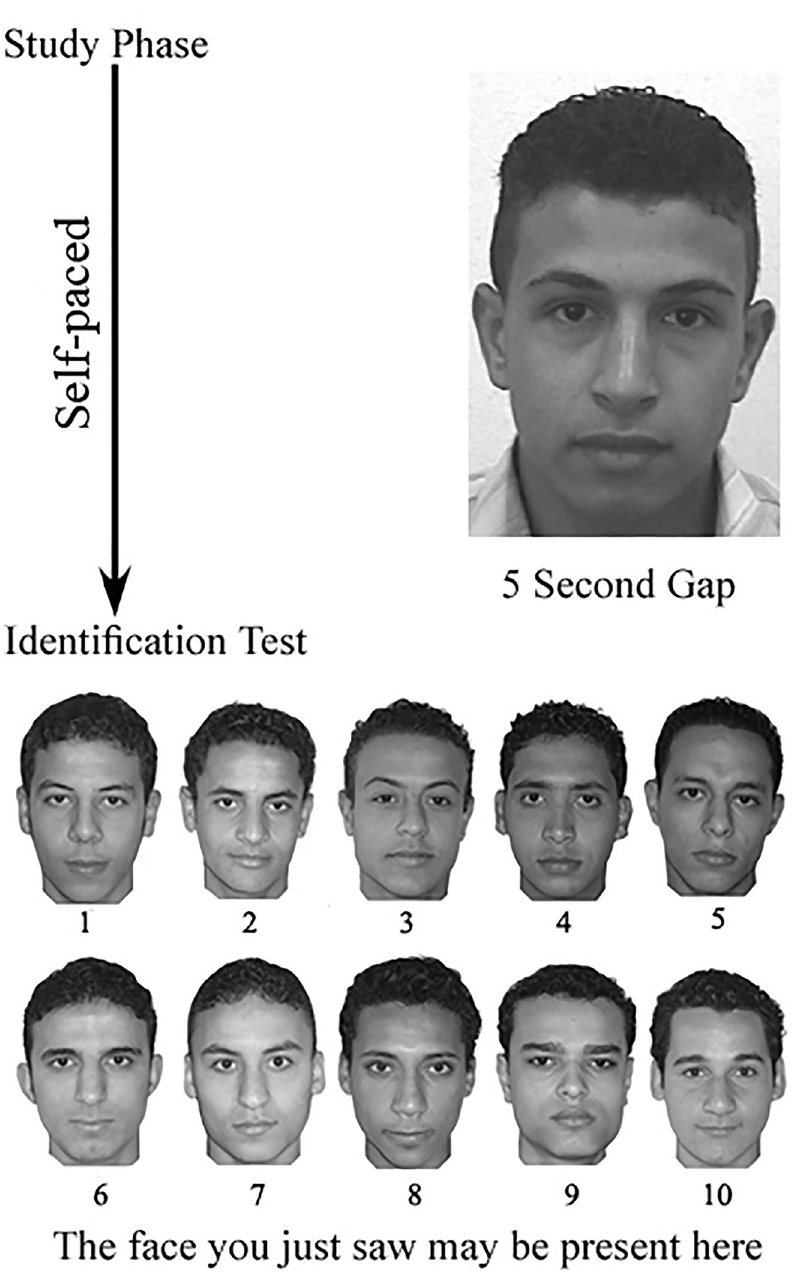
Fig 1. A schematic representation of the unfamiliar immediate memory